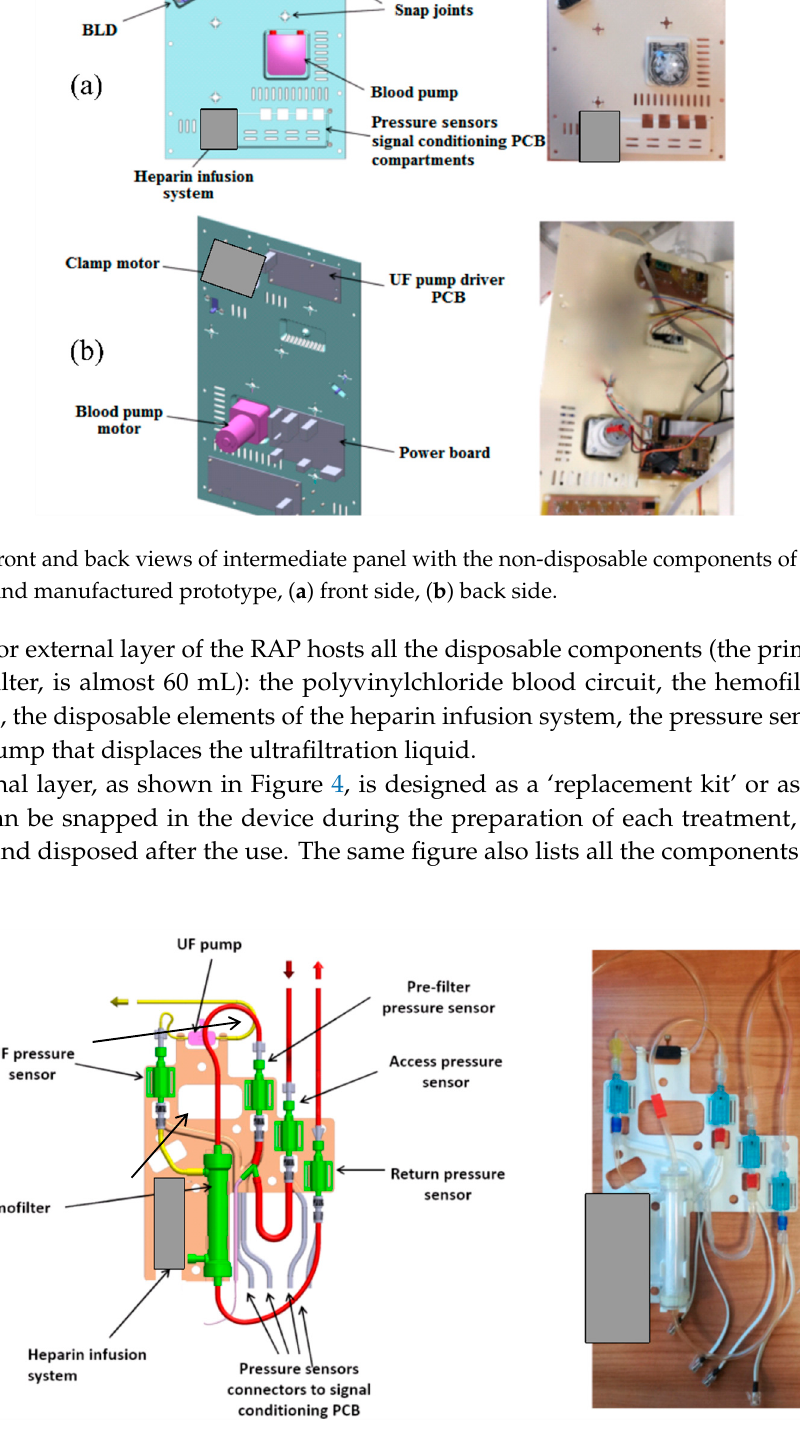
Figure 4. External panel with the disposable components of the RAP: 3D sketch and manufactured prototype.